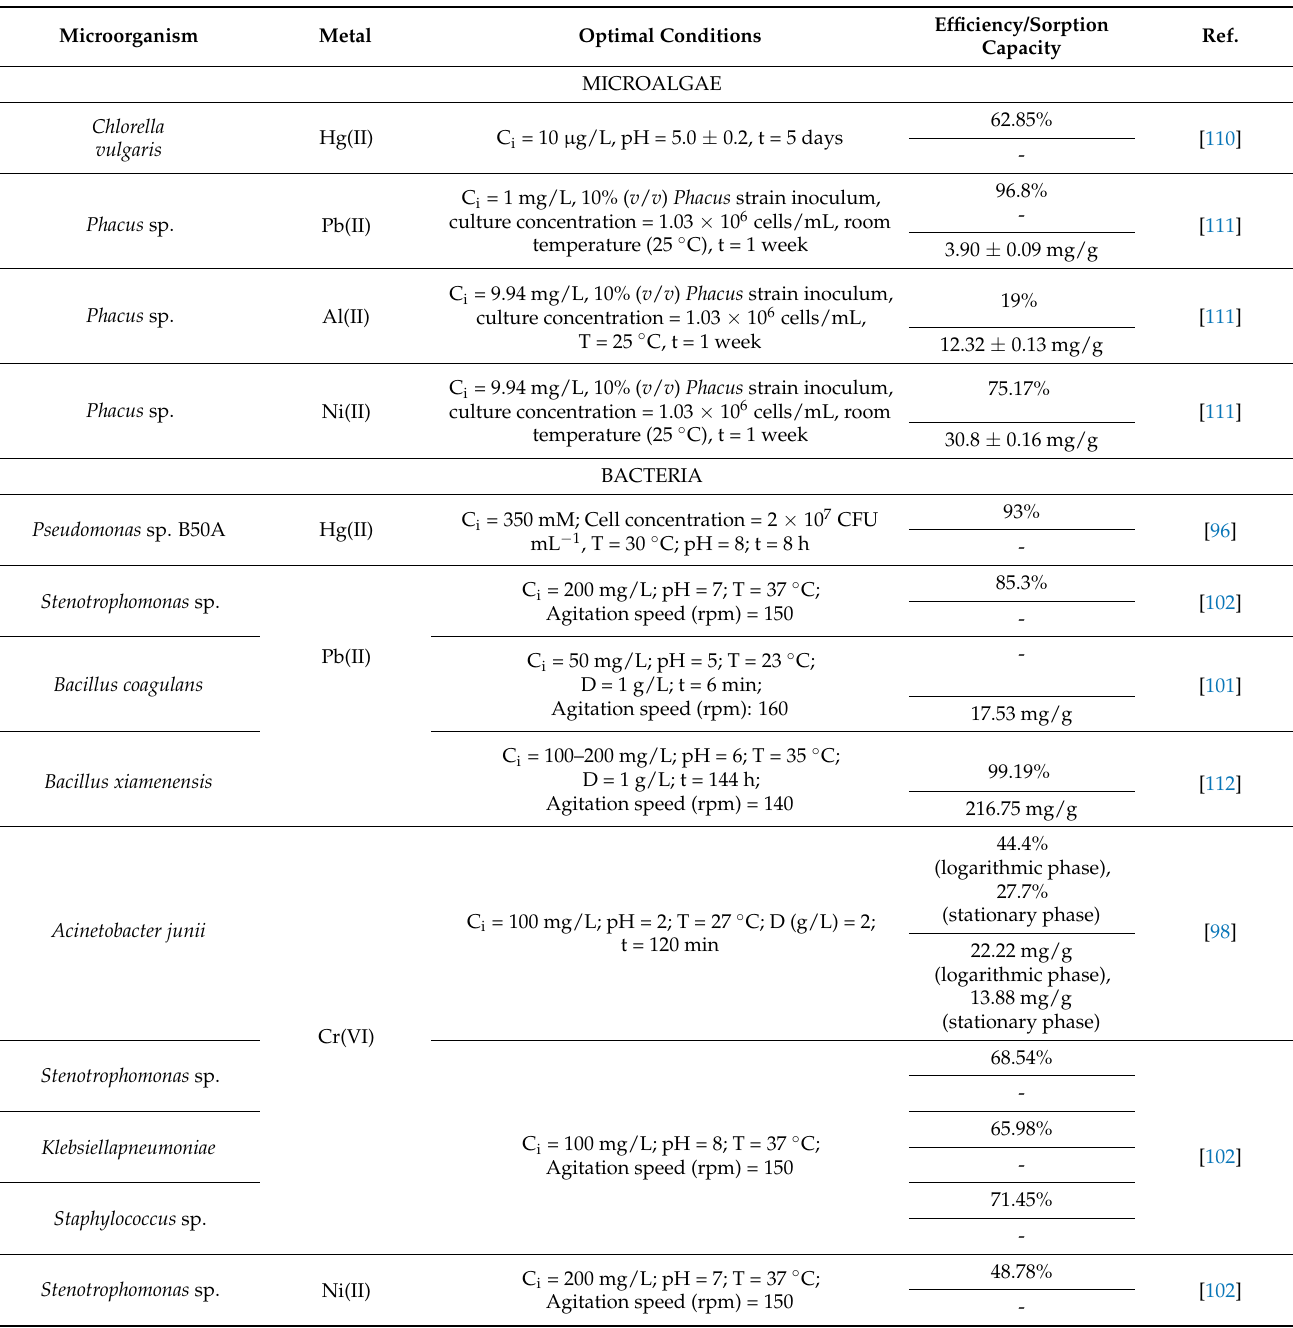
Table 1. Heavy metals removal by microbial living